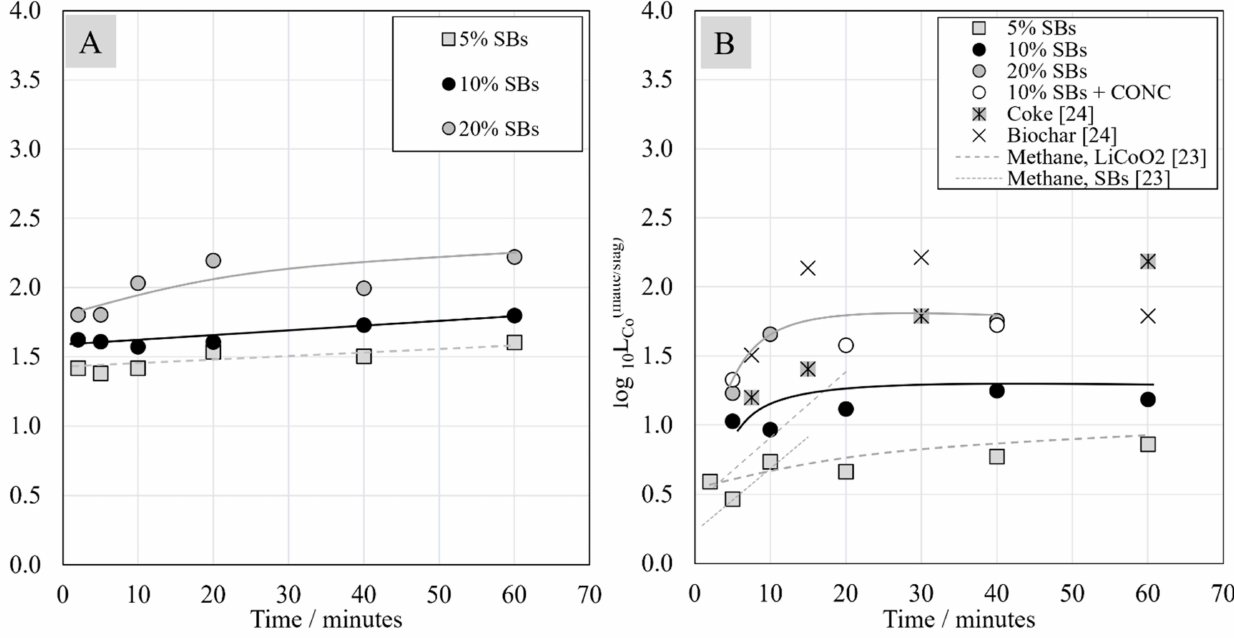
Figure 13. Distribution coefficient of cobalt between metal alloy and the slag ( A ) and between matte and the slag ( B ) as a function of contact